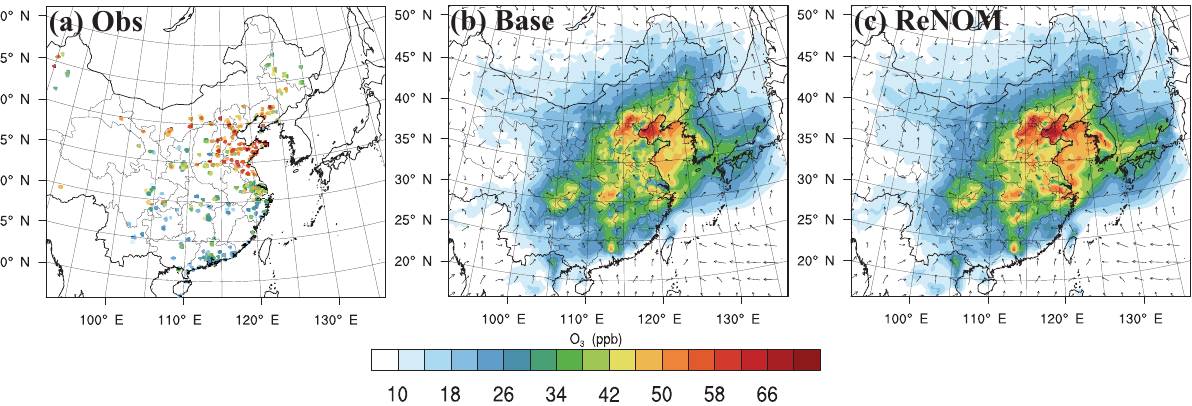
Figure 7. (a) Observations of O 3 at China MEP stations; spatial distributions of modeled O 3 concentrations in (b) base case and (c) ReNOM case